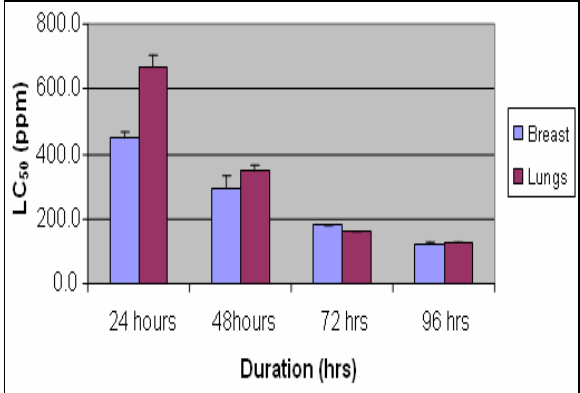
values of 2,6 DNT for breast and lung Figure 5: LC 50 cells exposed at various